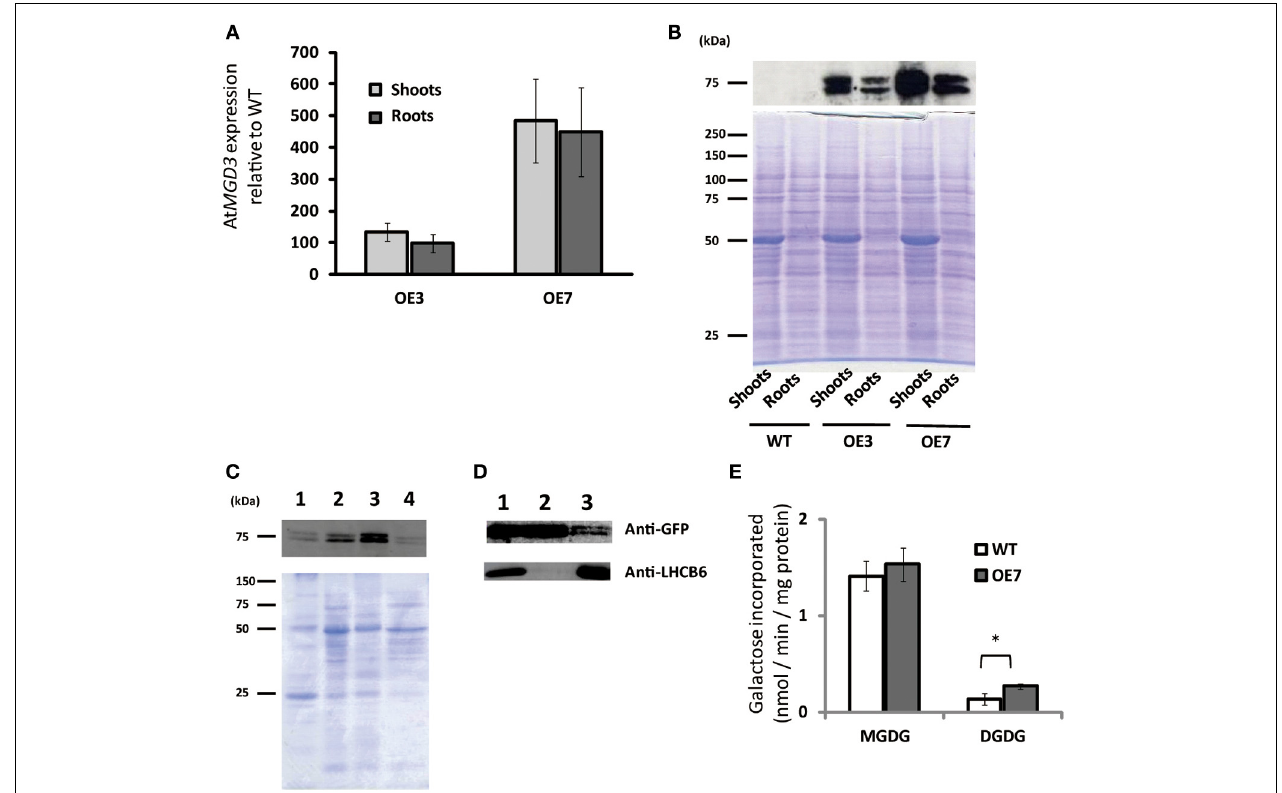
FIGURE 3 | Overexpression of At MGD3-GFP in Arabidopsis . Plants were grown on ½MS medium supplemented with 1% (w/v) sucrose ( + suc) for 14d. (A) Relative abundance of AtMGD3 mRNA in shoots and roots of two overexpression lines (OE3 and OE7) was analyzed by quantitative RT-PCR. The relative expression was normalized to the abundance of AtMGD3 mRNA in shoots and roots, respectively, of WT. Values represent the mean ± SD from three independent measurements. (B) Western blot analysis of At MGD3-GFP using anti-GFP. Crude-extract protein (20 μ g from shoots, 10 μ g from roots) was separated by SDS-PAGE, and bands were stained with Coomassie Brilliant Blue (lower panel) or transferred to a nitrocellulose membrane for western blotting (upper panel). (C) Microsomal localization of